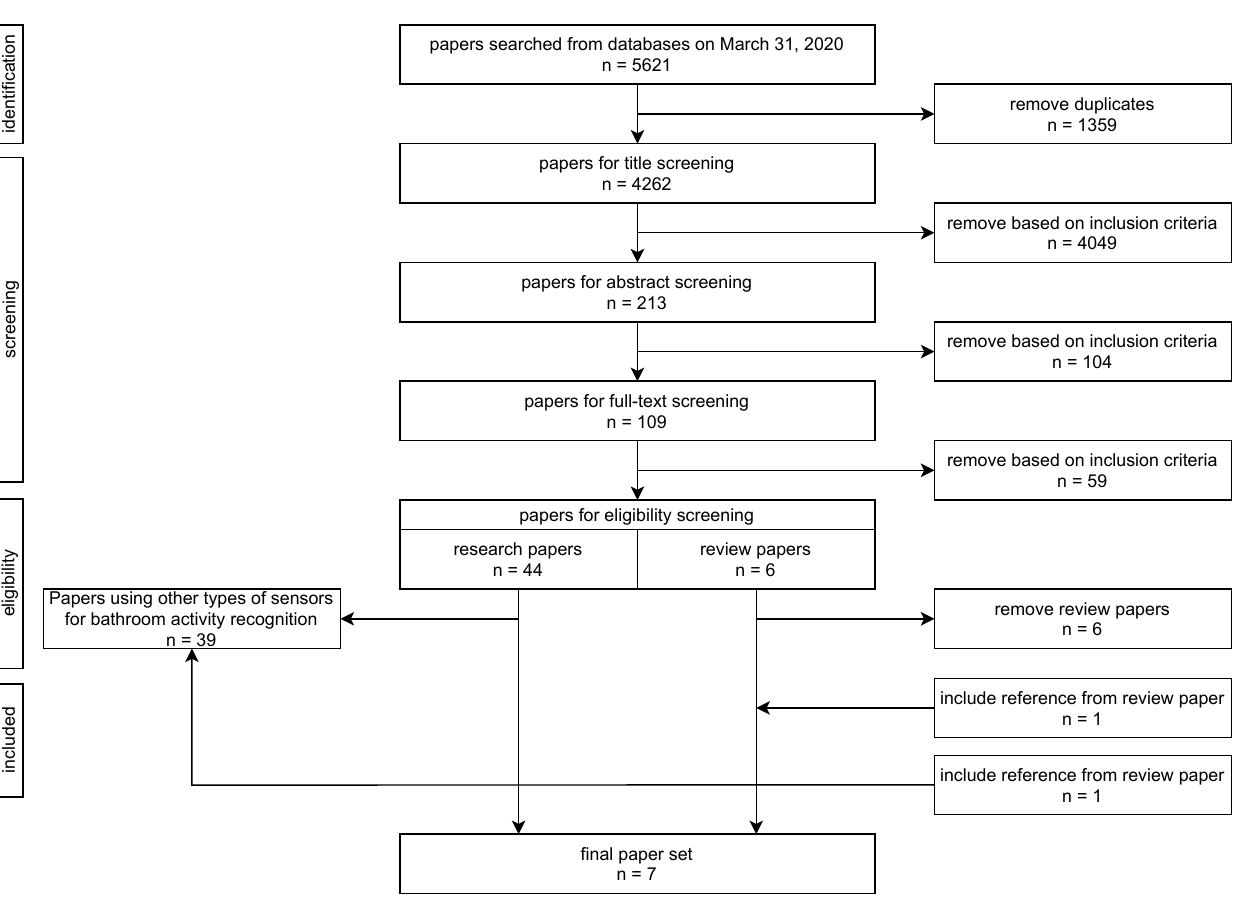
Figure 1. Flowchart of the paper screening